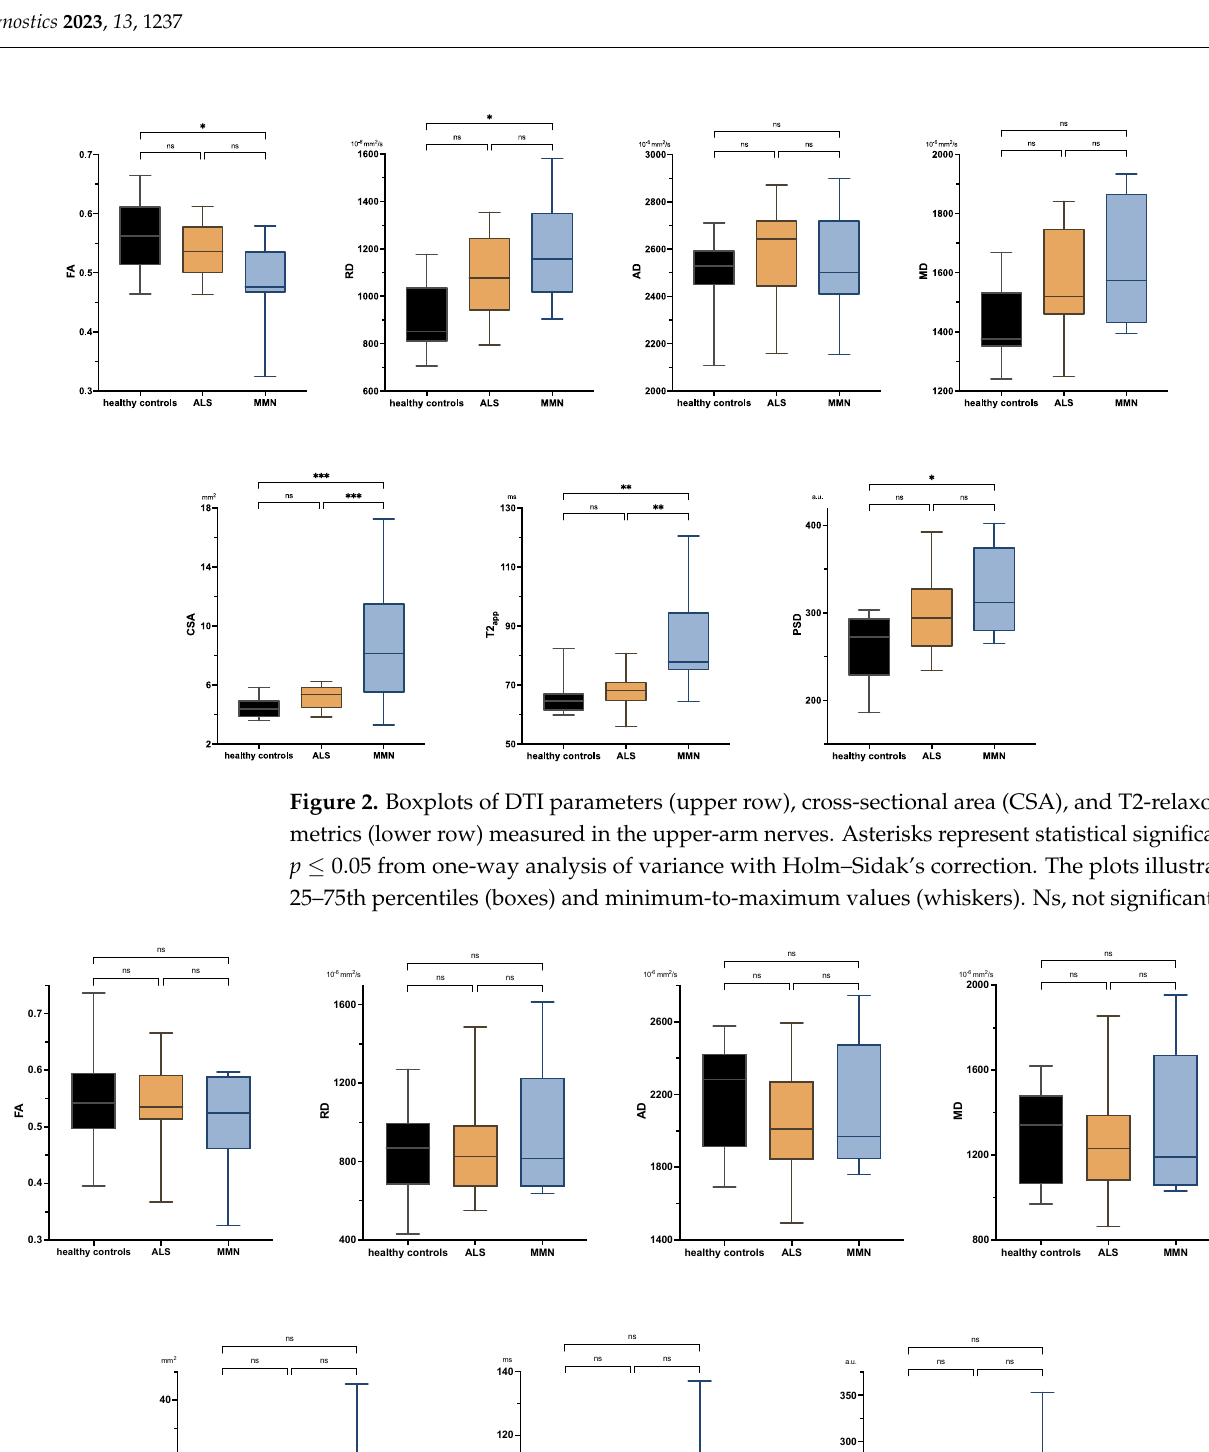
Figure 3. Boxplots of DTI parameters (upper row), cross-sectional area (CSA), and T2-relaxometry metrics (lower row) measured in the tibial nerve at the thigh. One-way analysis of variance with Holm–Sidak(cid:31)s correction, statistical signi fi cance was set at p ≤ 0.05. The plots illustrate the 25–75th percentiles (boxes) and minimum-to-maximum values (whiskers). Ns, not signi fi cant.